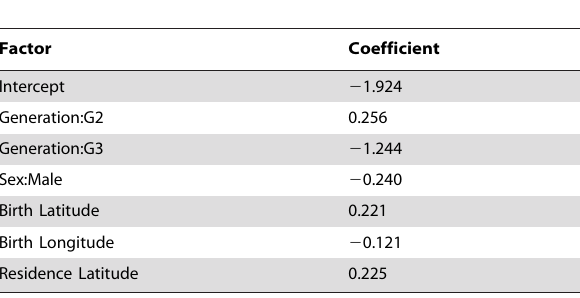
Table 2. Best model to explain probability of